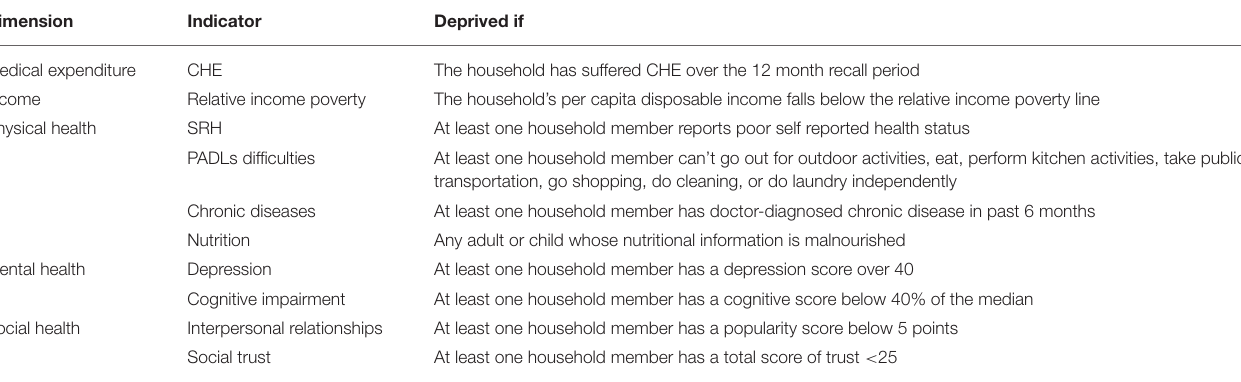
TABLE 3 | Dimensions, indicators, and cutoffs of the multidimensional health poverty index (MHPI).